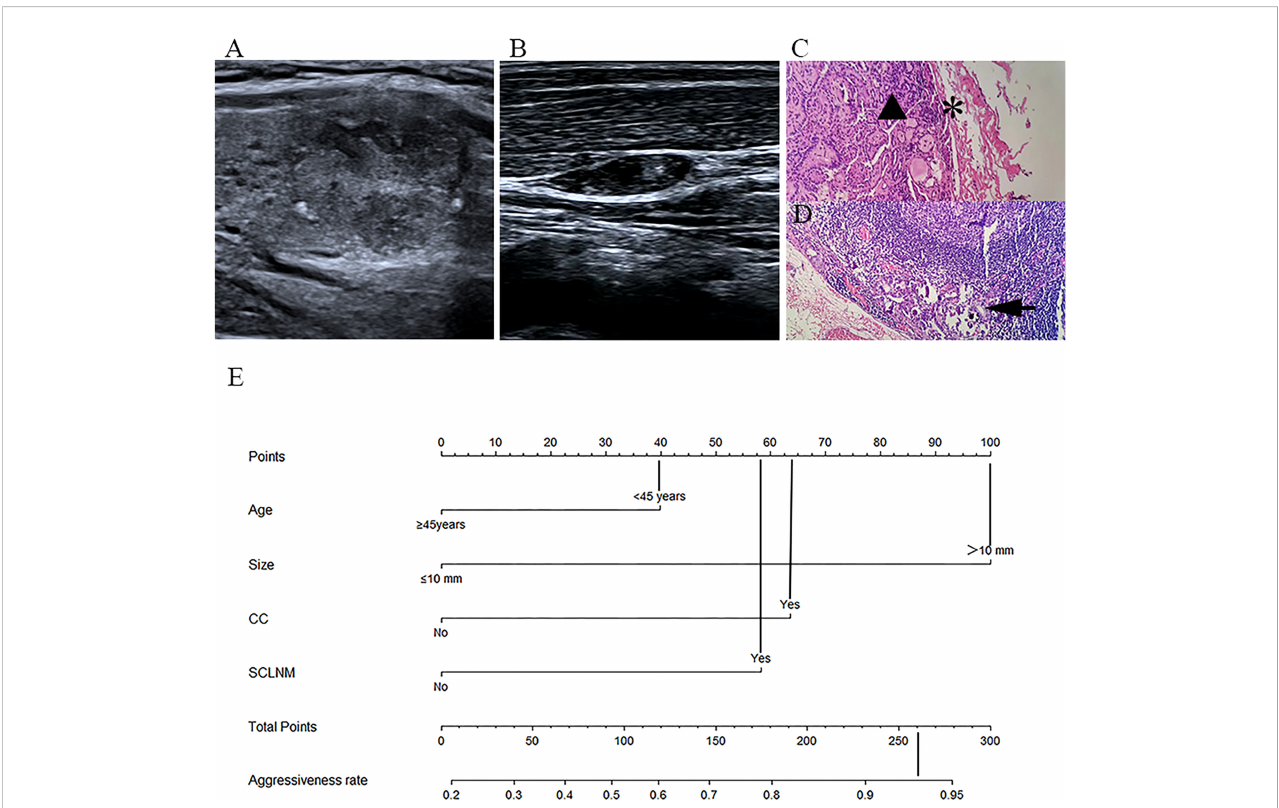
FIGURE 5 Example of nomogram usage for predicting aggressive papillary thyroid carcinoma. In patient 2 (female, 24 years old), preoperative fi ne needle aspiration cytology con fi rmed papillary thyroid carcinoma in the right lower part of the thyroid. (A) Conventional ultrasound showed that the tumor size was 17.8 mm, with capsule abutment (CA). (B) Conventional ultrasound on the right lateral neck level IV indicated suspected cervical lymph node metastasis (SCLNM) with loss of the fatty hilum and microcalci fi cations. Postoperative pathological assessments (C, D) revealed PTC (triangular) in fi ltrating the thyroid capsule (stellate) and metastasis (arrow) of the ipsilateral lateral neck lymph nodes ( HE staining, 400×). On the nomogram (E) , the total score was approximately 260, and the predicted probability of aggressiveness was greater than